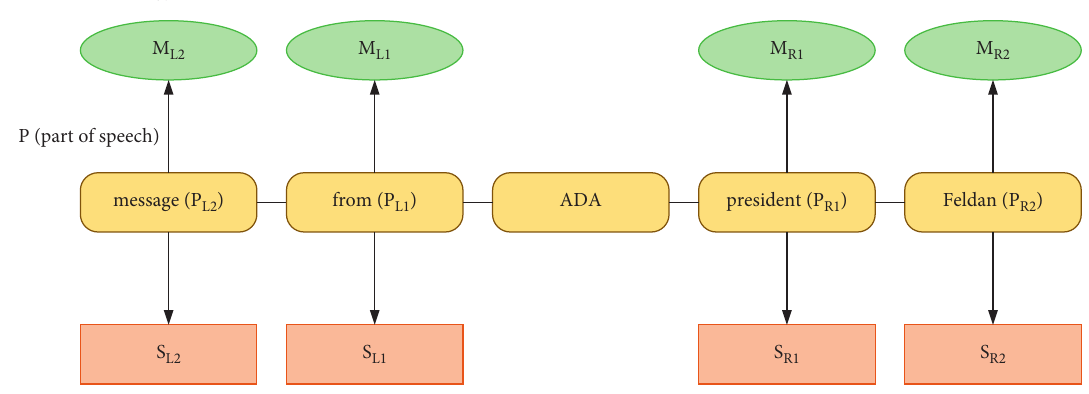
Figure 1: Extract disambiguation features.